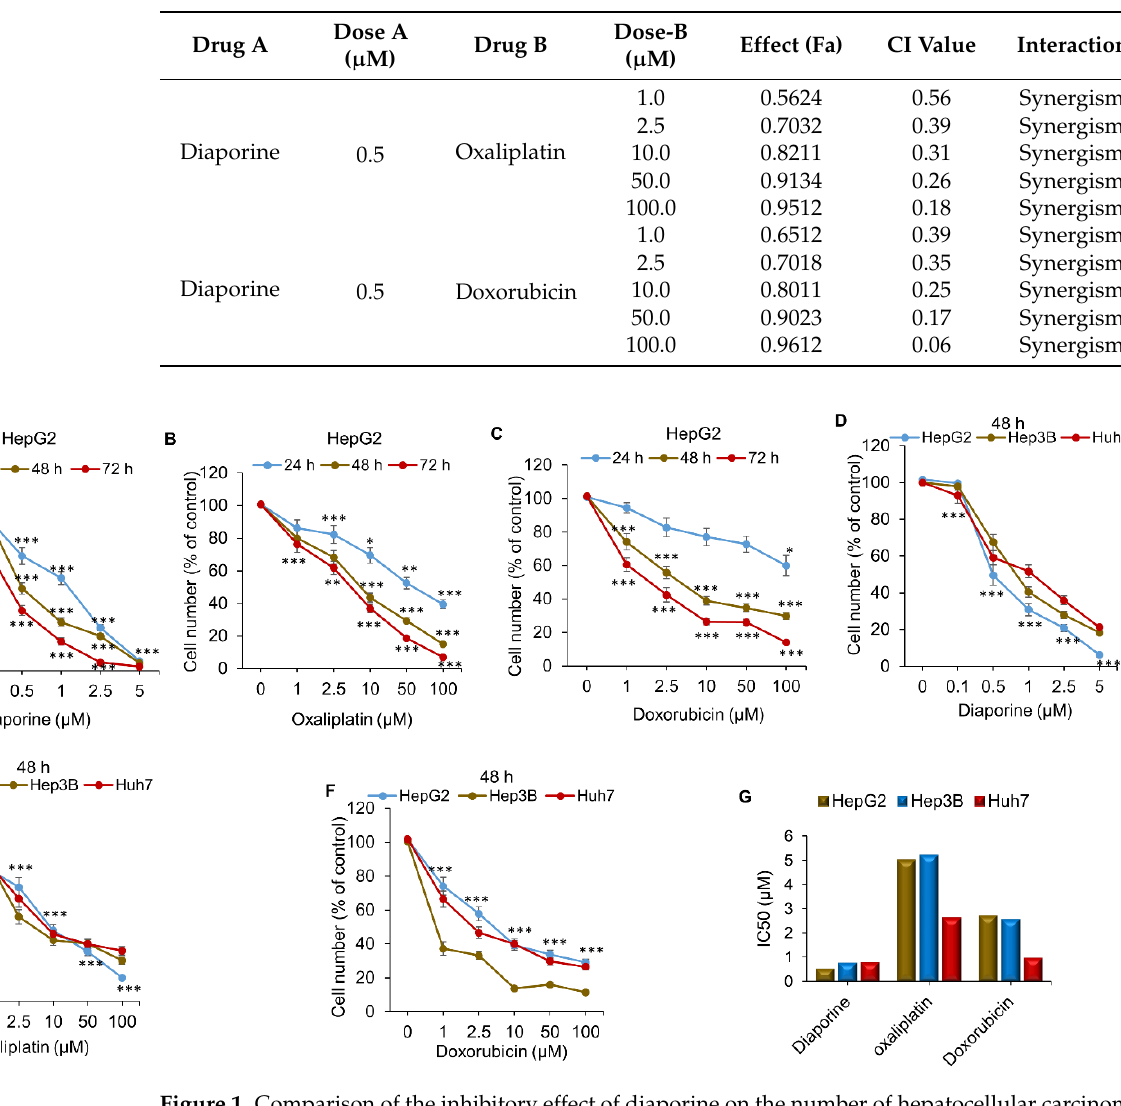
Table 1. The nature of drug interactions in HepG2 cells treated with diaporine and combined with oxaliplatin or doxorubicin.